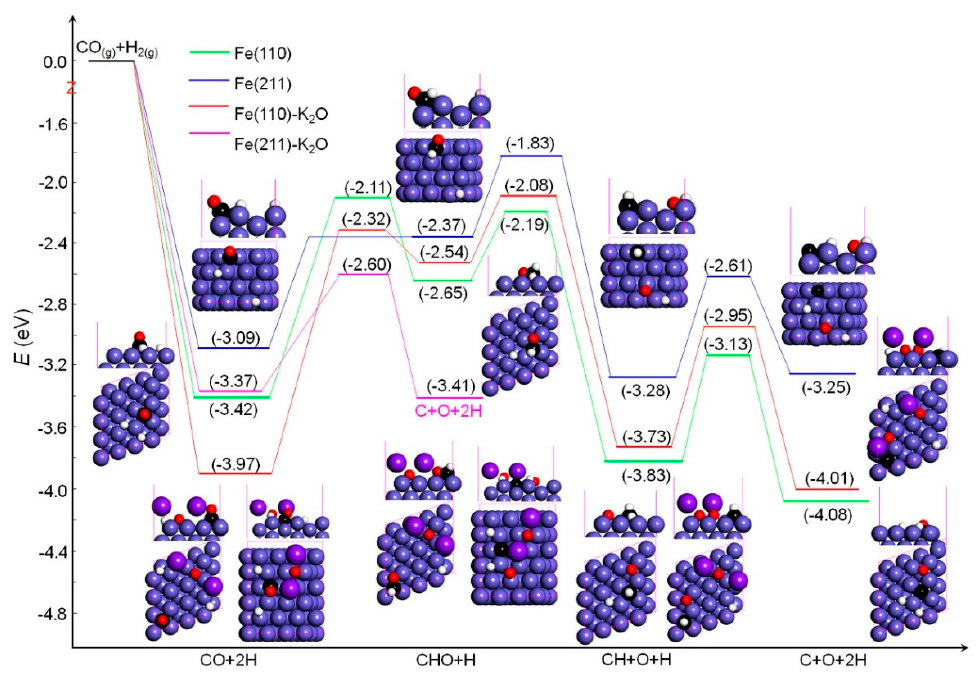
Figure 4. The most favorable pathways of CO/H 2 dissociation on the Fe(110), Fe(110)-K 2 O, Fe(211) and Fe(211)-K 2 O, as well as the top and side view of the configurations for the corresponding intermediates. The Fe, K, O, C and H atoms are given in grayish blue, purple, red, black and white, respectively.